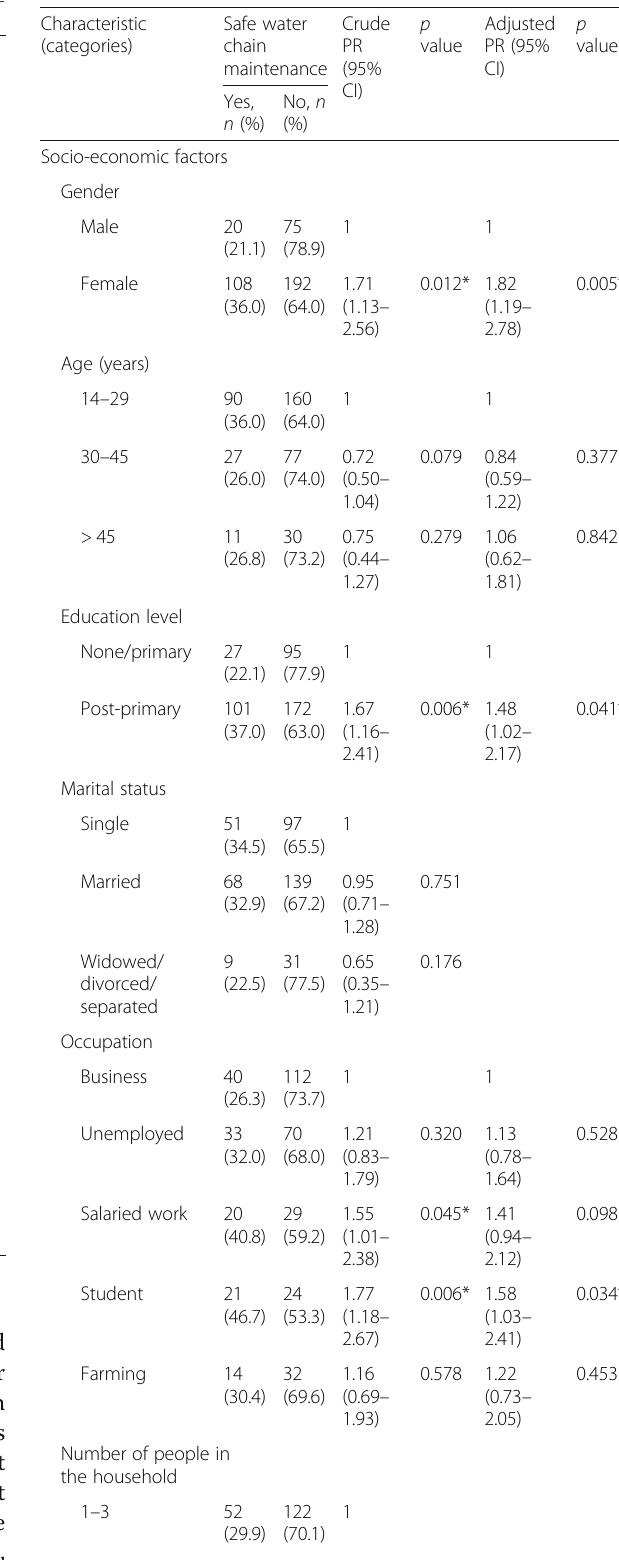
Table 5 Practices on safe water chain maintenance Variables Frequency ( n =